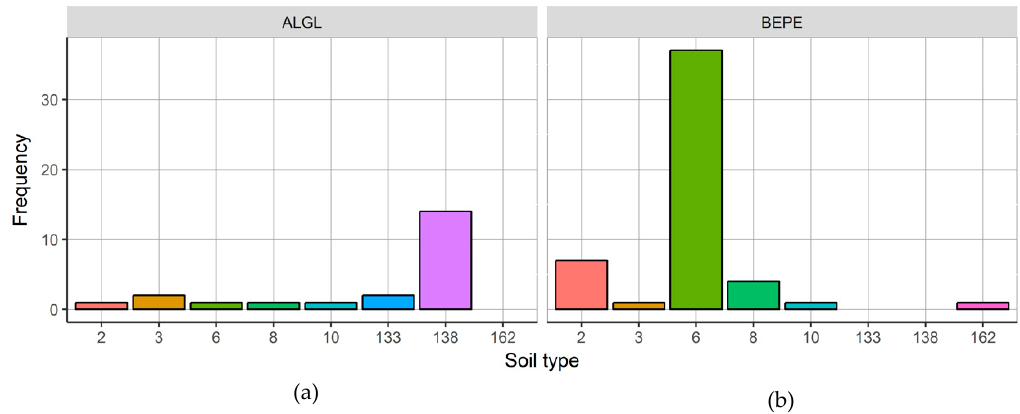
Figure 2. Distribution of the training dataset for ( a ) black alder and ( b ) silver birch between soil types.